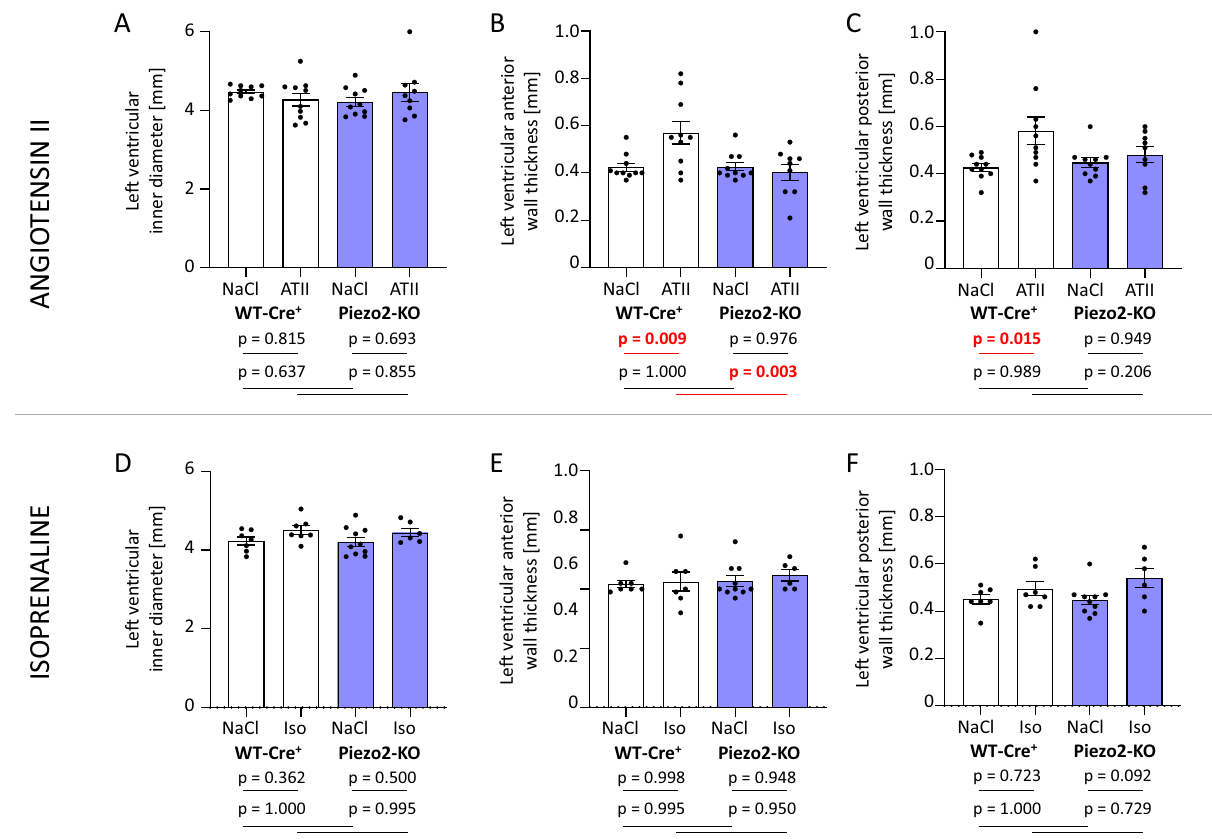
Figure 6. Dimensions of the left ventricle of WT-Cre + and Piezo2-KO mice after angiotensin II or isoprenaline treatment. Echocardiographic assessment of ( A ) left ventricular inner diameter, ( B ) left ventricular anterior wall thickness and ( C ) left ventricular posterior wall thickness after three weeks of angiotensin II (ATII) treatment. Accordingly, ( D ) left ventricular inner diameter, ( E ) left ventricular anterior wall thickness and ( F ) left ventricular posterior wall thickness were assessed after one week of isoprenaline (Iso)